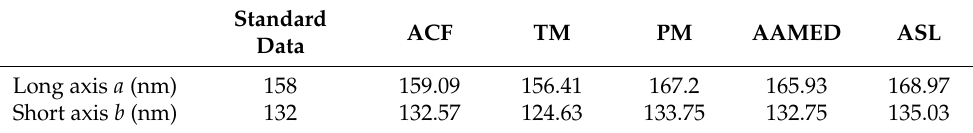
Table 1. Standard data and the results of the compared methods on dataset 1.